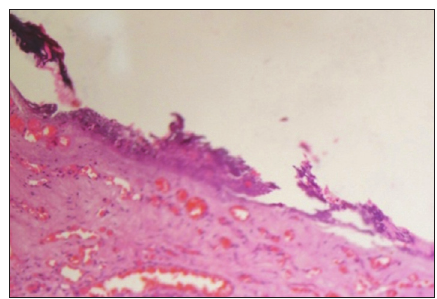
Figure 9: Photograph showing postoperative view: Day